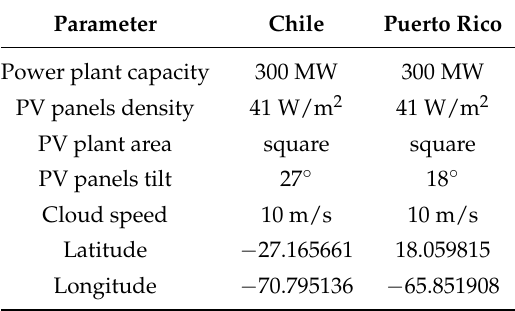
Table 2. Wavelet variability model (WVM) settings.